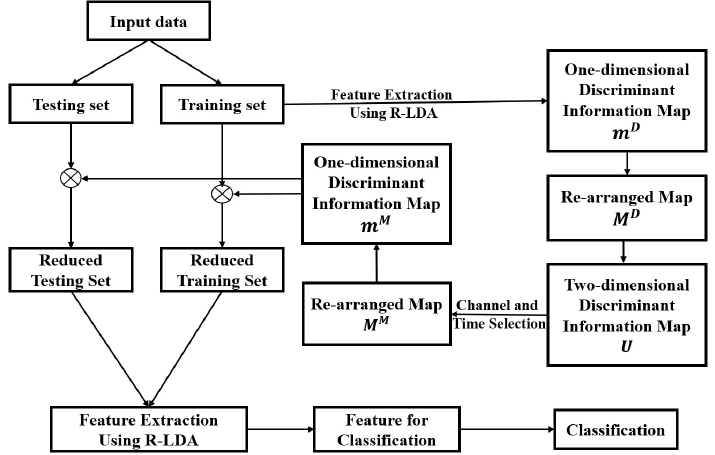
Figure 4. Overall procedure of the proposed